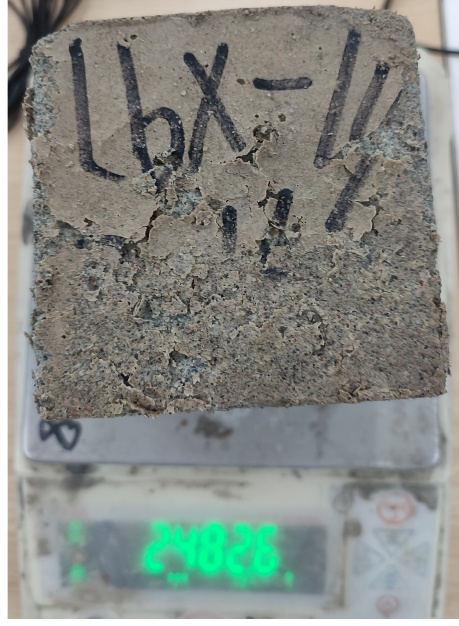
Figure 6. Mass loss test after sulfate attack.